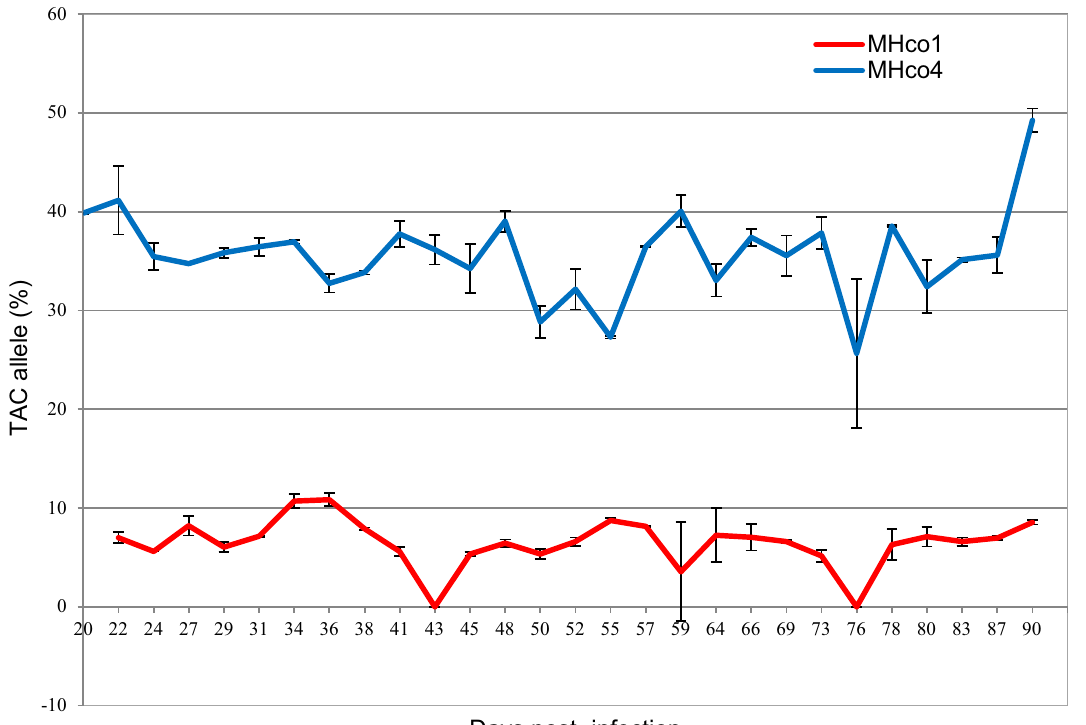
Figure 1. Mean ± SD of the β-tubulin benzimidazole resistance-associated allele (TAC) at codon 200 in the susceptible and resistant isolates of H. contortus during the course of an experimental infection (20–90